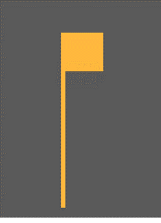
Figure 2. Schematic diagram of the micro voltage sensor.